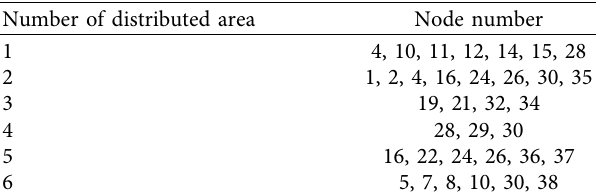
Figure 5: Partition modularity of IEEE 39-node system. Table 1: Partition results of IEEE39 node